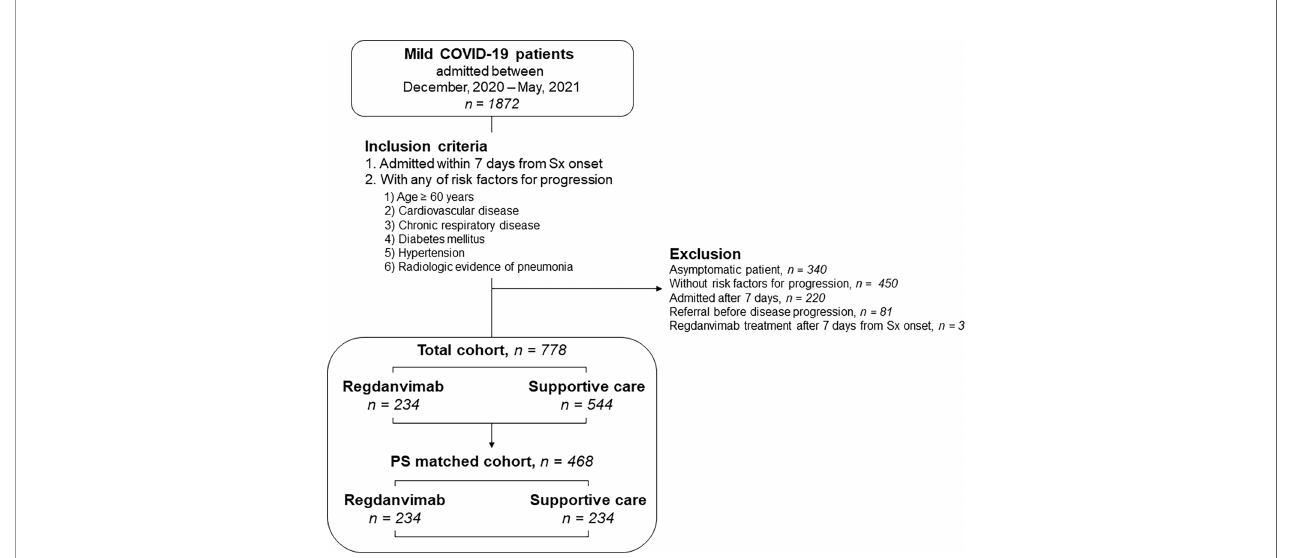
FIGURE 1 | Patient selection for the retrospective cohort. Mild COVID-19 patients admitted to two hospitals designated for COVID-19 patient care were screened. High-risk patients who were admitted within 7 days of symptom onset were included. The effects of regdanvimab treatment were evaluated using multivariate analyses in the total cohort and in propensity score – matched cohorts developed to adjust for potential confounders. COVID-19, coronavirus disease 2019; Sx, symptom; PS, propensity